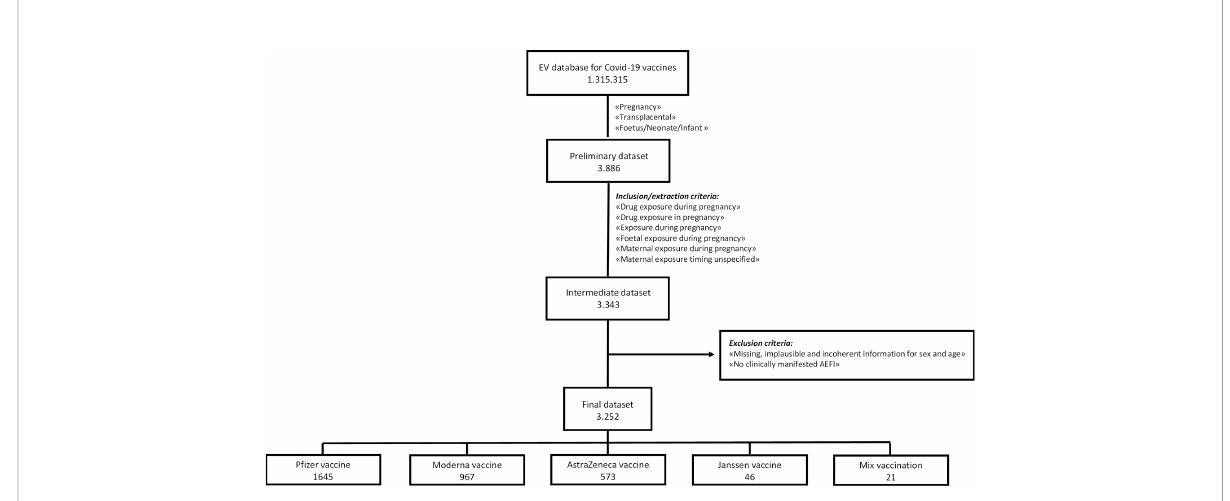
FIGURE 1 Flowchart of the selection process of ICSRs from the EudraVigilance database. AEFI, adverse event following immunization; EV,